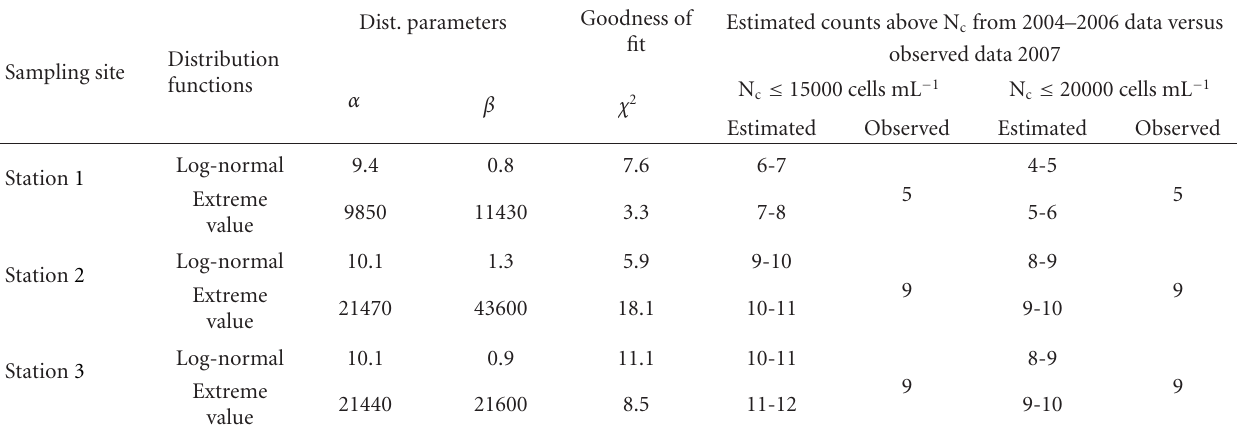
Table 3: Parameters, goodness of fit measure and estimated frequency of Microcystis aeruginosa above specified values for each distribution function versus observed frequencies at each sampling site.